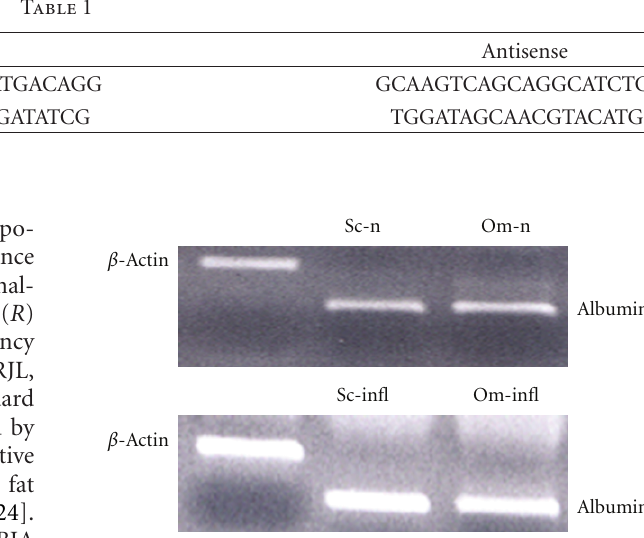
Figure 1: Albumin gene expression obtained by RT-PCR in subcutaneous (Sc) and Omental (Om) adipocytes from normal healthy subjects (Sc-n and Om-n, resp.) and inflamed patients (Sc- infl and Om-infl, resp.). β -Actin gene expression is also reported as housekeeping. The image is representative of all the